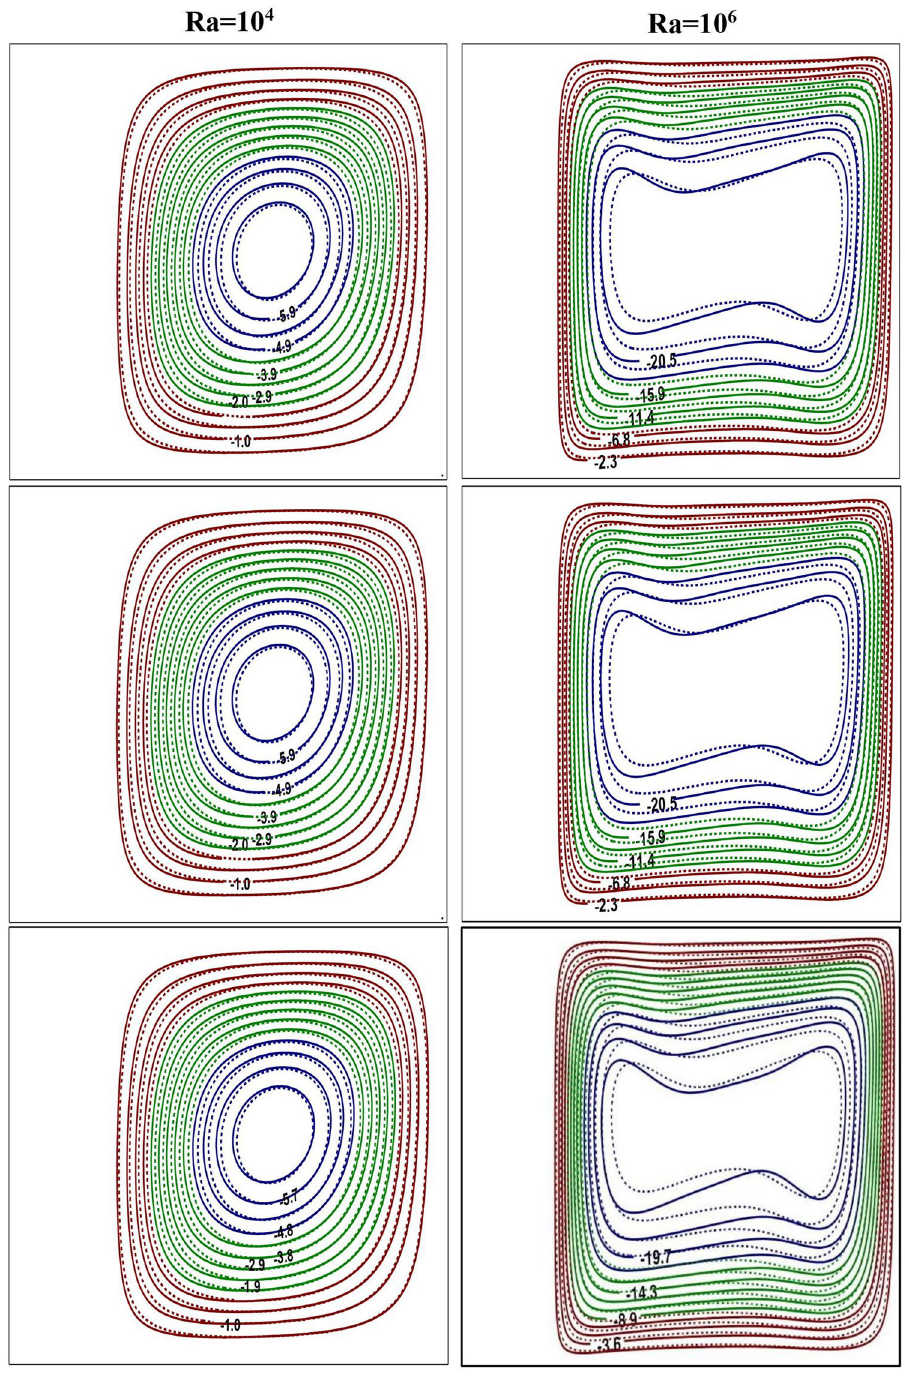
4 (left) and Ra = 10